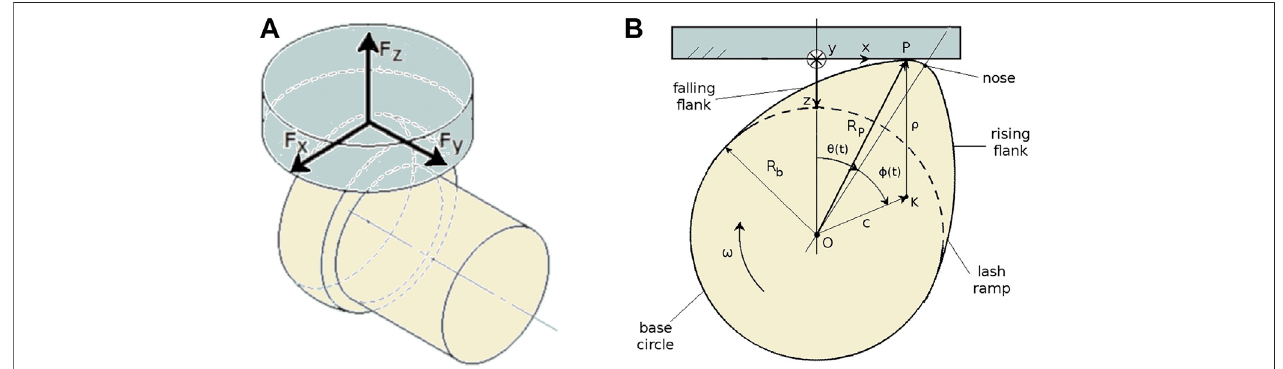
FIGURE 4 | Reference systems used for the forces exerted on the follower (A) and for the kinematics of the cam (B) .